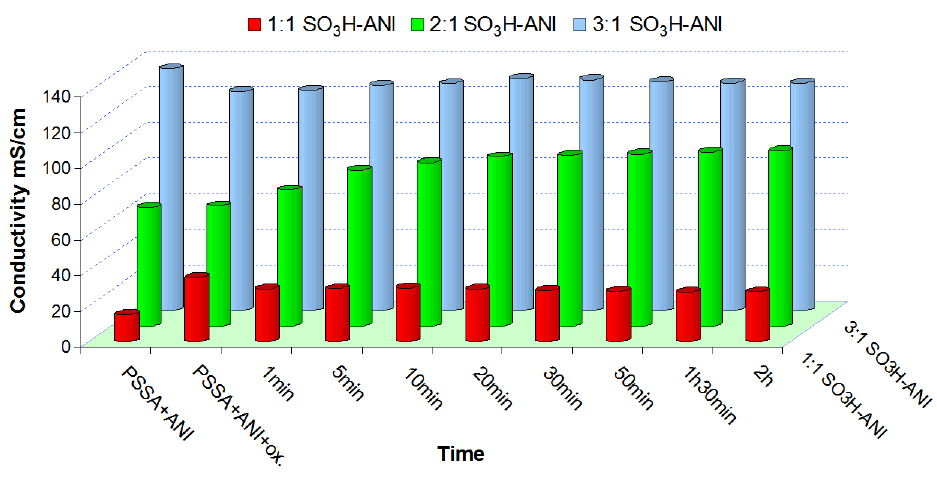
Figure 7: Conductivity of PSSA-ANI solutions at three molar ratios recorded during anyline polymerization (at 25 °C), initial pH = 4.35.